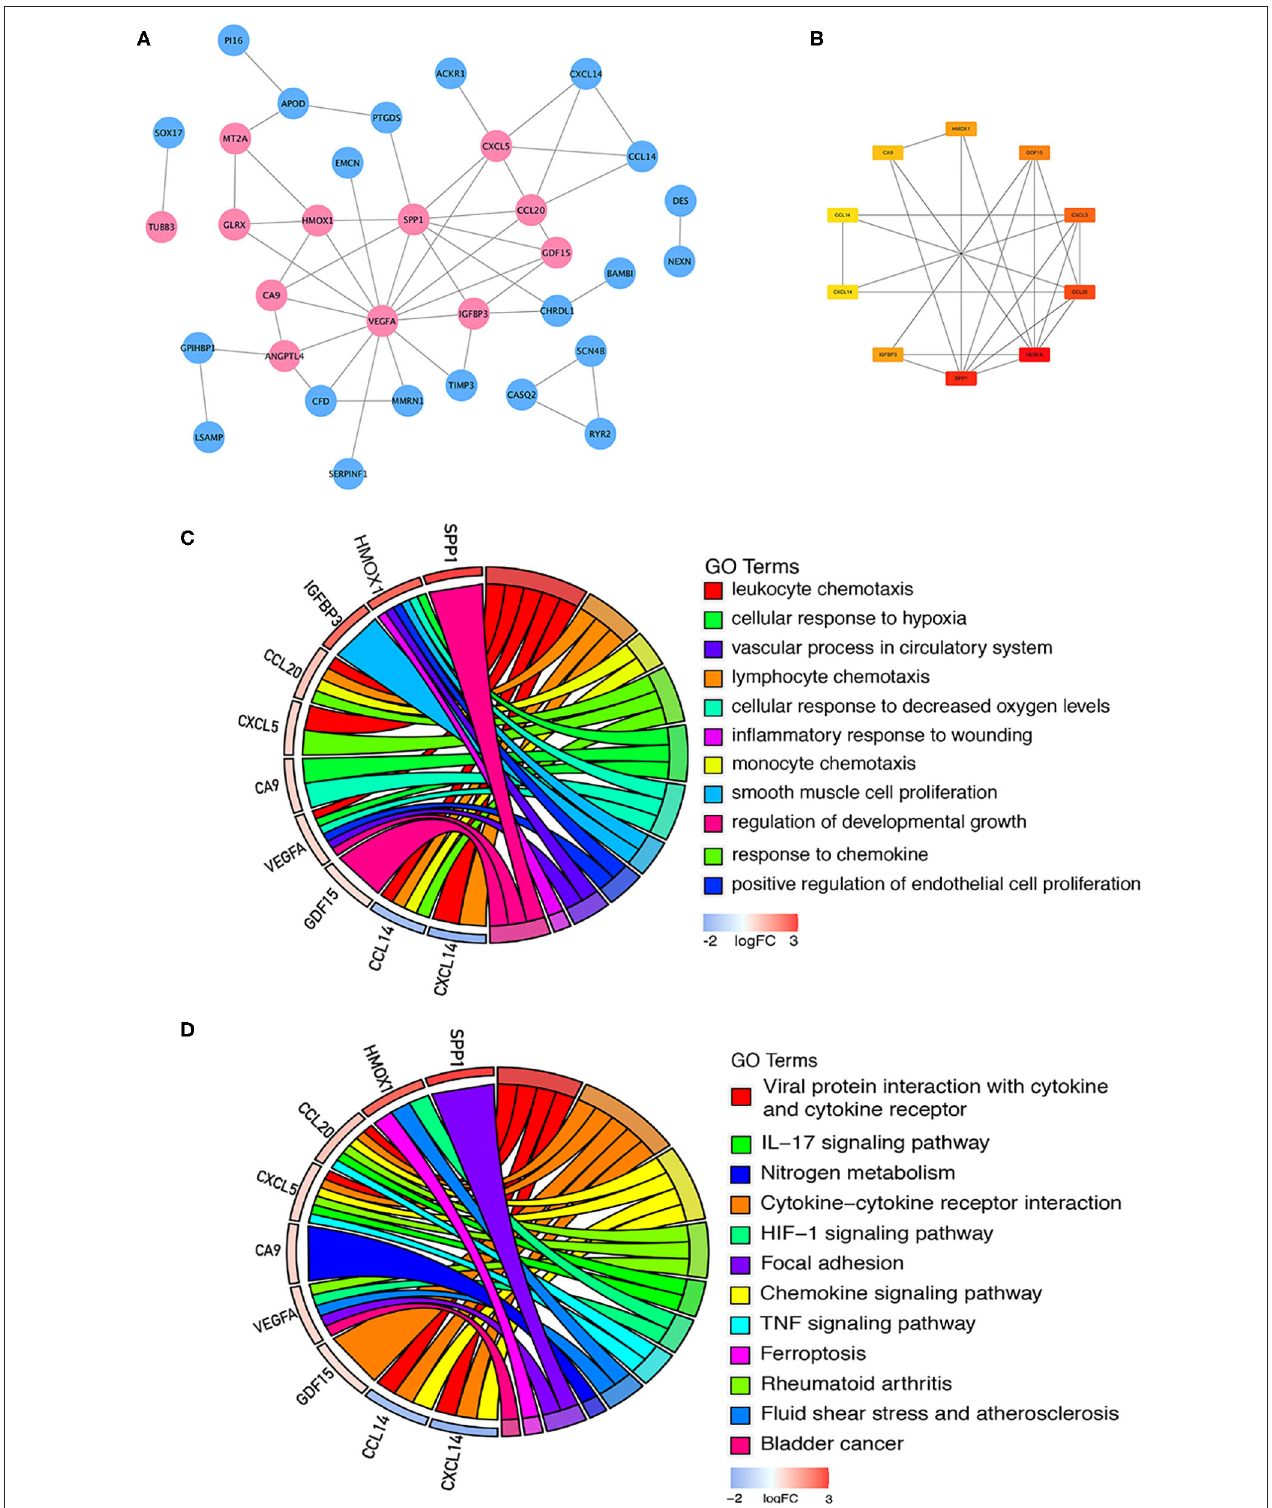
FIGURE 5 | PPI network construction and enrichment analysis of the hub genes. (A) PPI network constructed with the integrated DEGs. The red nodes represent upregulated proteins, and the blue nodes represent downregulated proteins. (B) Top 10 hub genes calculated by the MCC method in CytoHubba software. The gradation of color represents the value of the score according to the MCC method, and the VEGFA score was the highest. (C) GO functional annotation analysis of the top 10 genes. (D) KEGG pathway enrichment analysis of the top 10 genes.